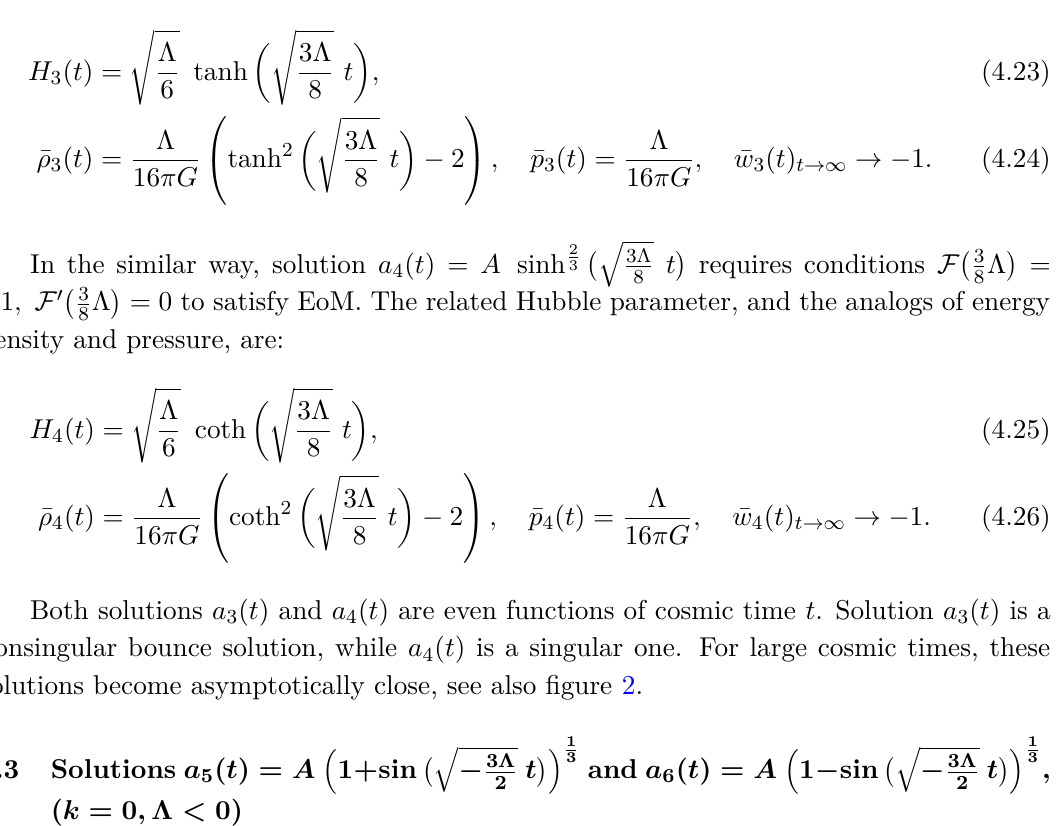
(cid:0)q (cid:0)q (cid:1) , (red) and (cid:1) , (blue) are 3Λ 3Λ t a 4 ( t ) = A sinh 2 3 t 8 8 ( t ) and H ( t ) are on the right 3 4